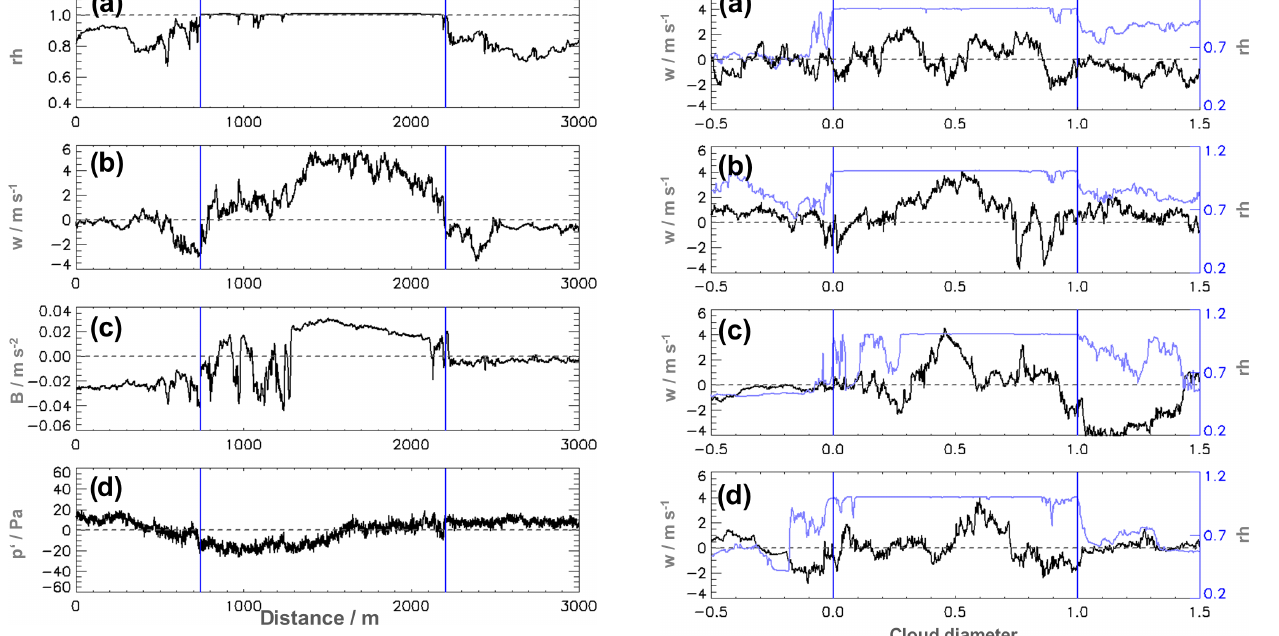
Figure 6. Relative humidity (blue line) and vertical wind (black line) for four along-wind-directed cloud transects of an individ- ual cloud during flight 2. The vertical blue lines indicate the cloud boundaries. The x axis is scaled to the horizontal diameter of the cloud, where 0 marks the cloud edge on the upwind side and 1 the downwind edge. The data outside the cloud are shown for half a cloud diameter each. The start time of the transect, cloud length and height of the flight level are for panel (a) 12:27UTC, 1043 and 2620ma.s.l.; panel (b) 12:33UTC, 1561 and 2620ma.s.l.; panel (c) 12:40UTC, 772 and 2920ma.s.l.; and panel (d) 12:42UTC, 673 and 2940ma.s.l.,